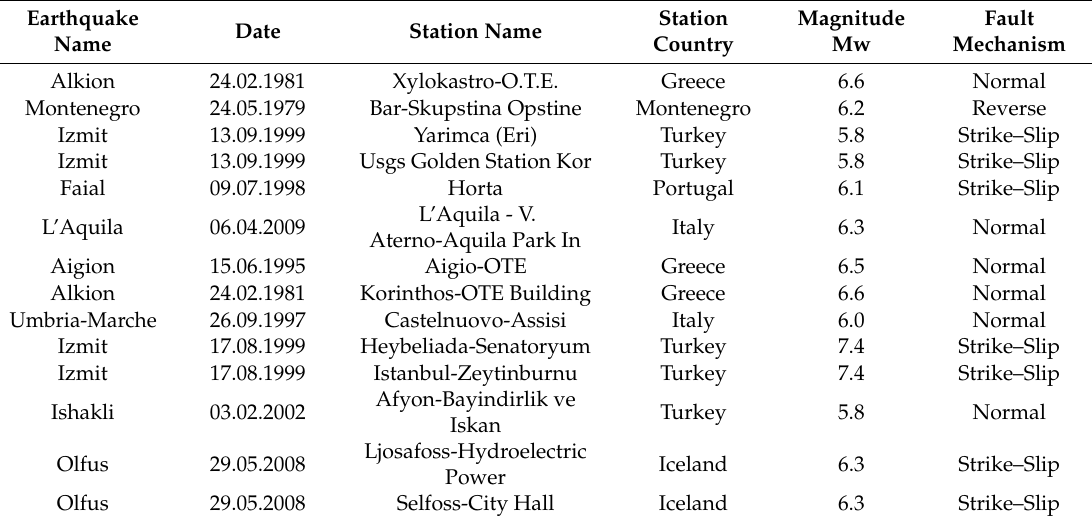
Table 5. Data of selected ground motion.